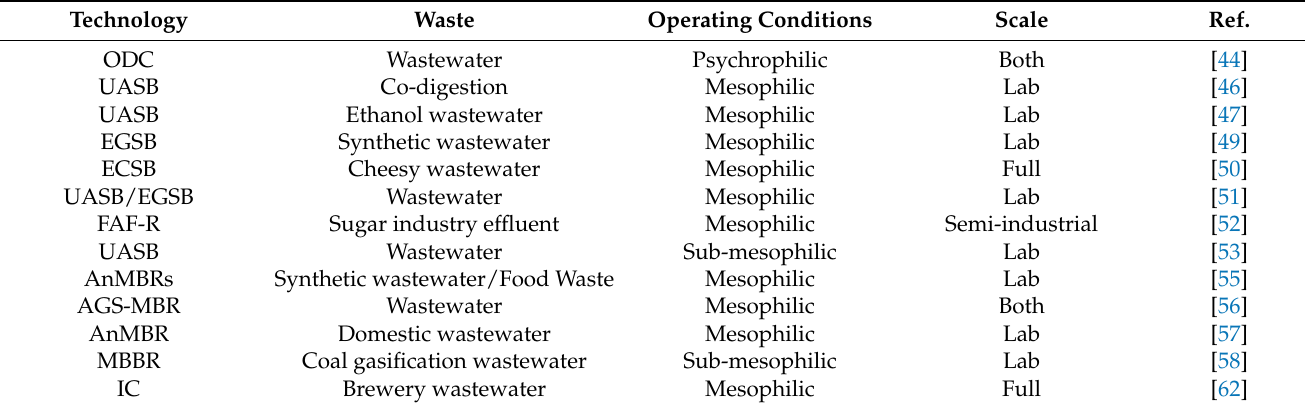
Table 2. Comparison between studies on advanced